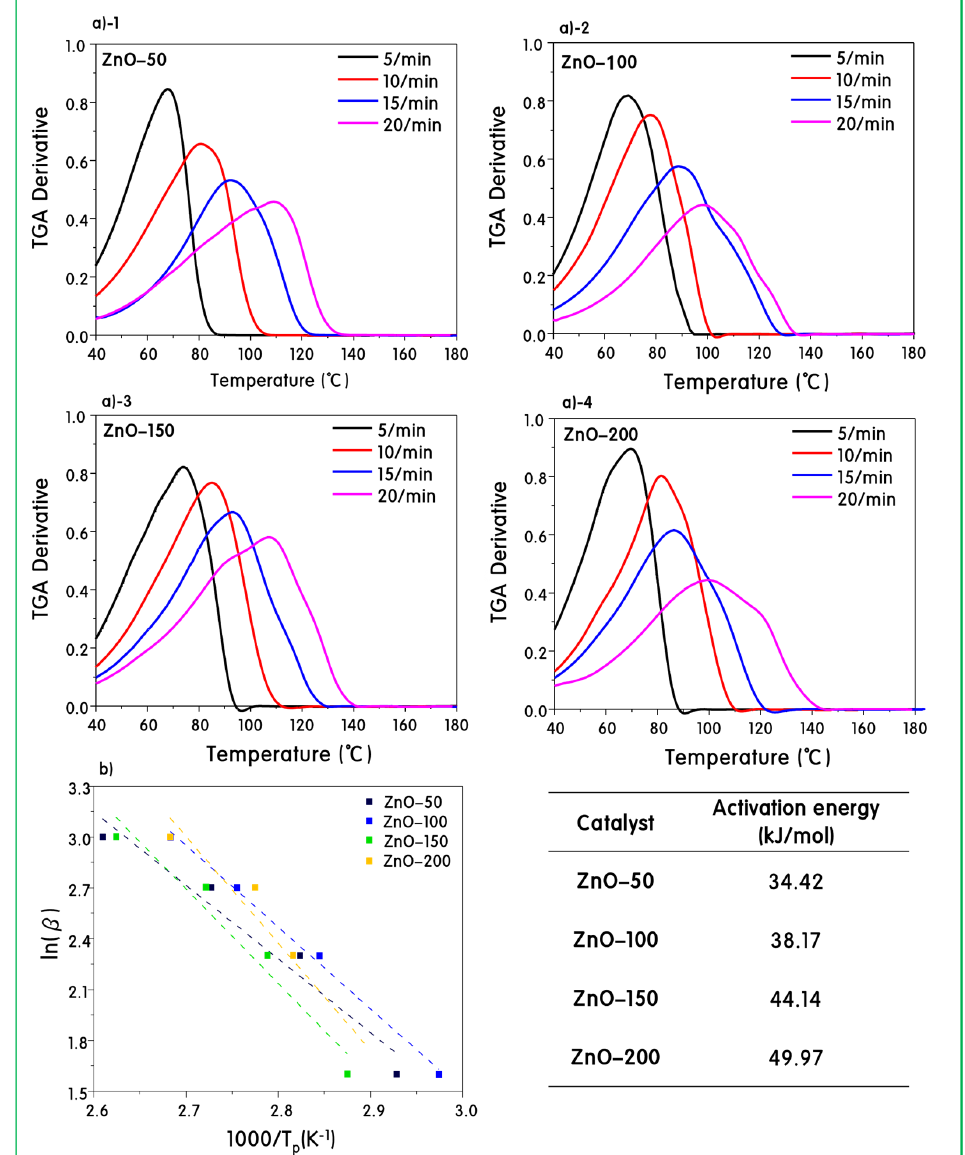
Figure 6. Water activation energy ( a1 – a4 ) Change in water desorption graph according to heating rate for each catalyst for TGA curve ( b ) Relationship between temperature and rate constant for water desorption for each catalysts.